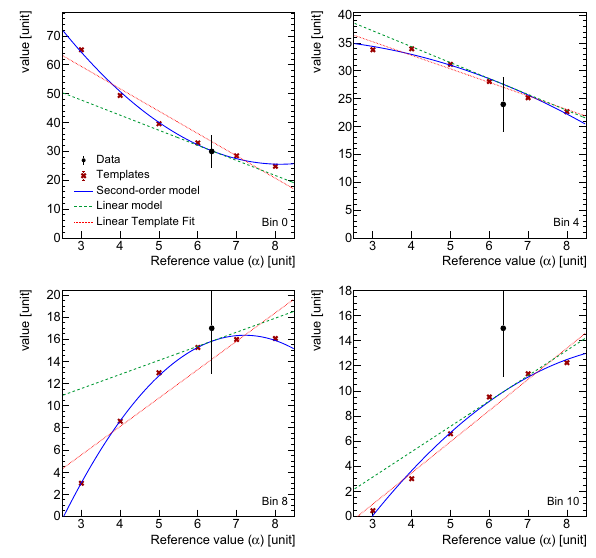
Fig. 6 Some illustrations of Example 3. Left: the template distribu- tions Y as a function of the observable, and more details are given in the caption of Fig. 1. Right: the templates Y for some selected bins. The blue line indicates a second-degree polynomial regression of the